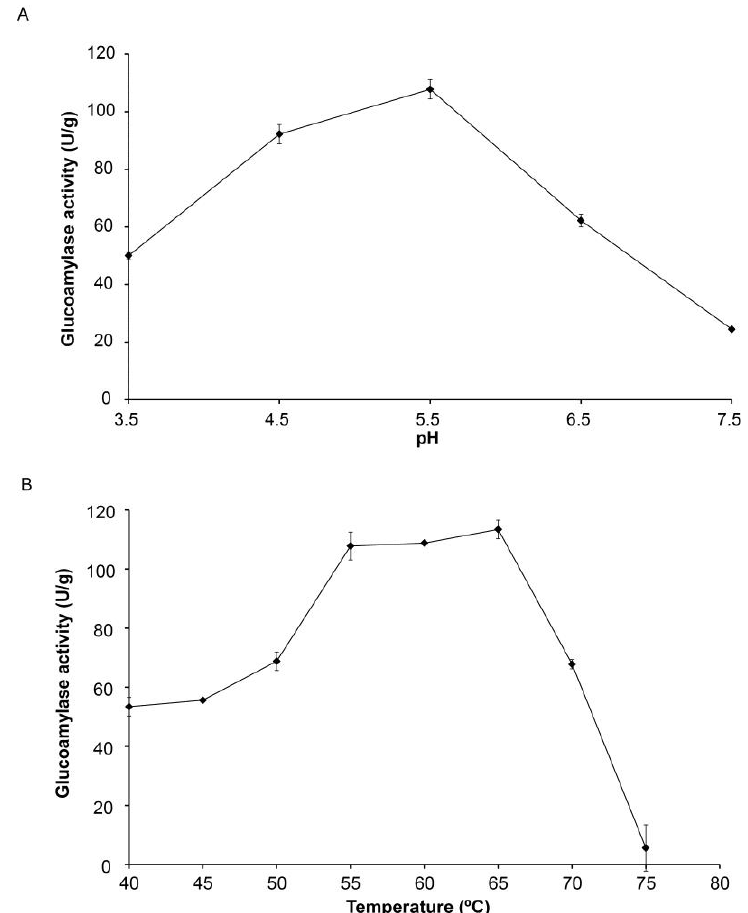
Figure 2. Effect of ( A ) pH at 55 °C and ( B ) temperature at pH 5.5 on crude GA extract activity. Experiments were duplicated. The mean values are plotted and the standard errors are